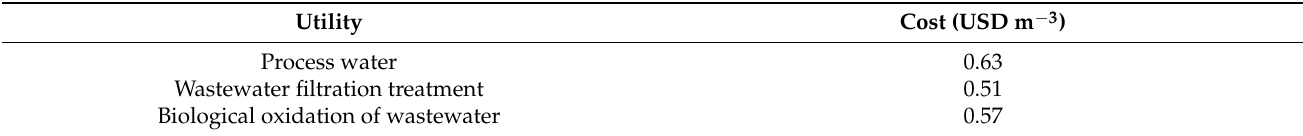
Table A12. Cost of process and wastewater